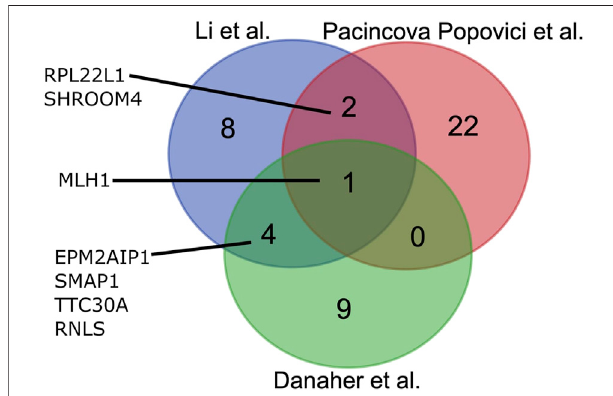
FIGURE 1 | Overlap between gene composition of MSI expression signatures developed by Li et al. (2020), Pa č ínková and Popovici (2019), and Danaher et al. (2019).